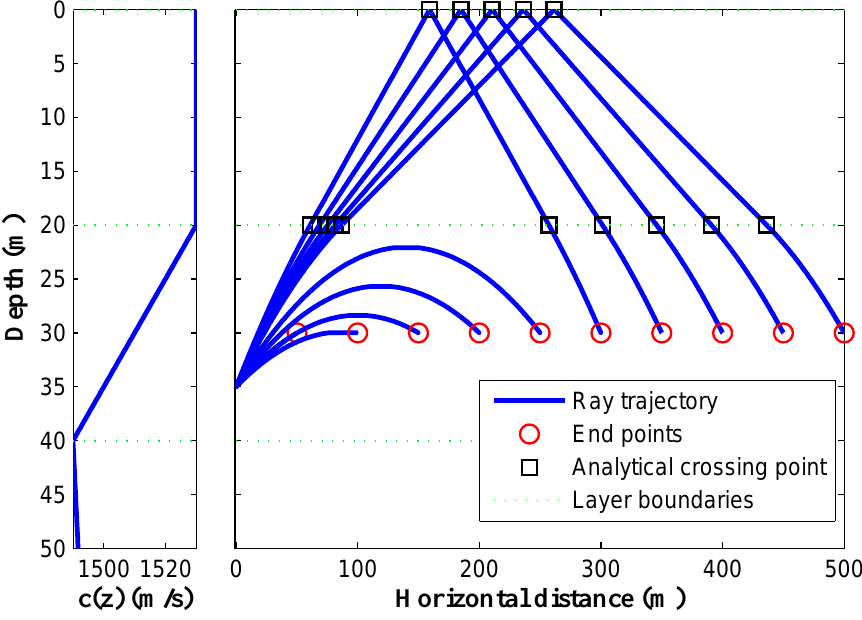
Figure 8. Sample of ray propagation between two nodes.